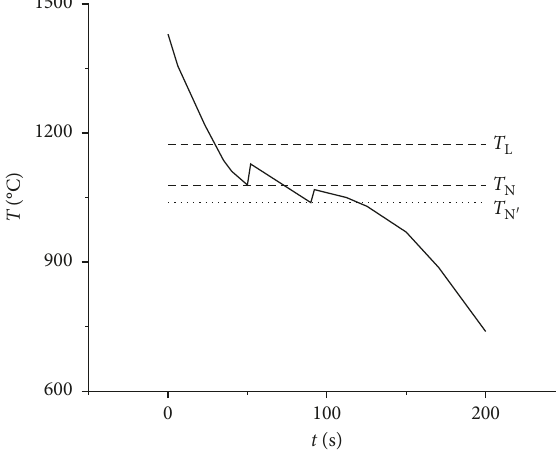
83 B 17 in nonequilibrium